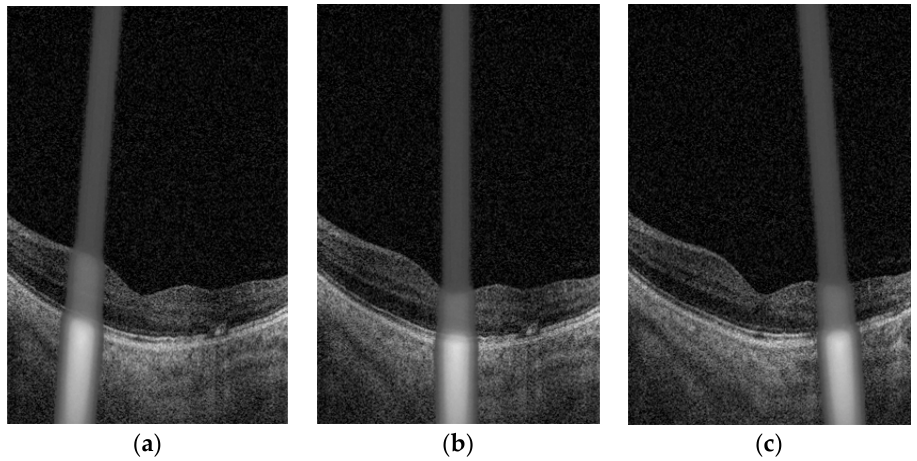
Figure 6. Simulation of thermal propagation at various coordinates for the point of influence along the oX axis: ( a ) 200 µ m; ( b ) 350 µ m; ( c ) 500 µ m.